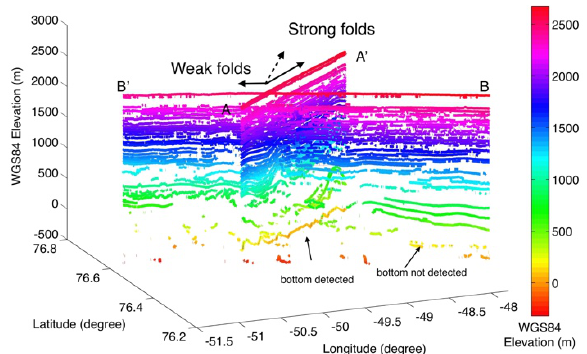
Figure 11. Linear features extracted from two intersected radar echograms shown in 3-D